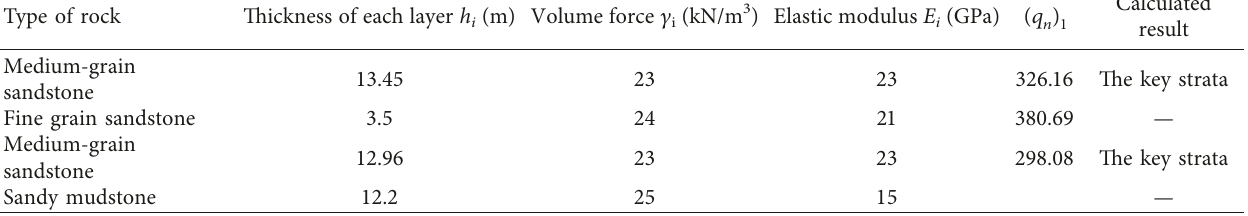
Table 2: #311103 working face key strata calculation statistics